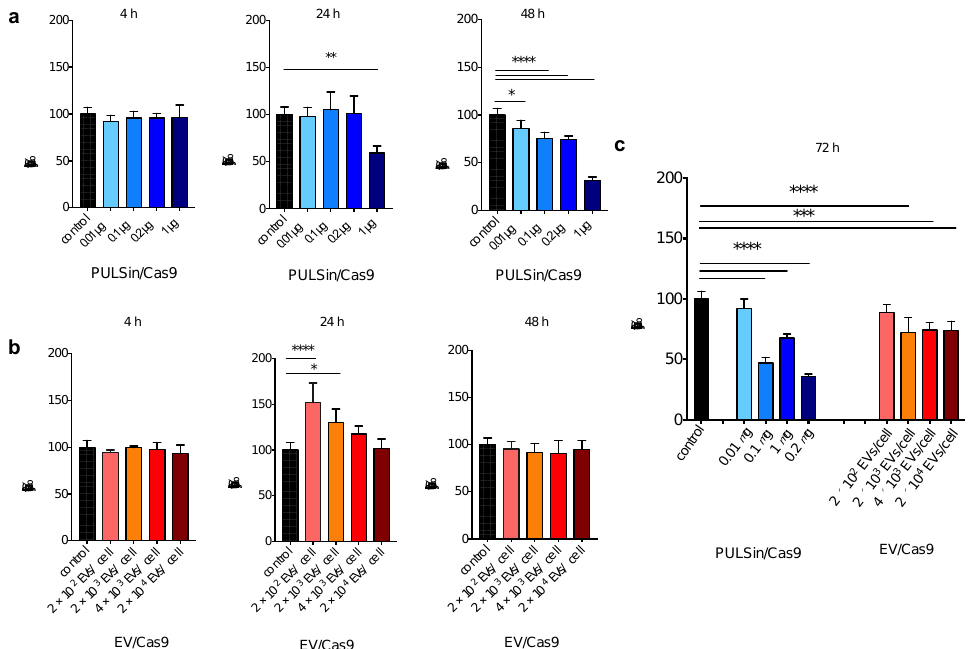
Figure 5. Viability of RAW 264.7 cells exposed to Cas9-loaded PULSin or Cas9-loaded EVs. ( a ) Cells treated with Cas9-loaded PULSin 4, 24, and 48 h. ( b ) Cells treated with Cas9-loaded EVs 4, 24, and 48 h. ( c ) Cells treated with Cas9-loaded PULSin or Cas9-loaded EVs for 72 h. Data are normalized to untreated control cells (data is shown twice in a and b for comparison purposes) and presented as mean ± SD of five replicates. Statistical analysis was performed by one-way ANOVA with post-hoc pairwise comparisons using Tukey’s test. *, p < 0.05; **, p < 0.01; ***, p < 0.001; ****, p < 0.0001.